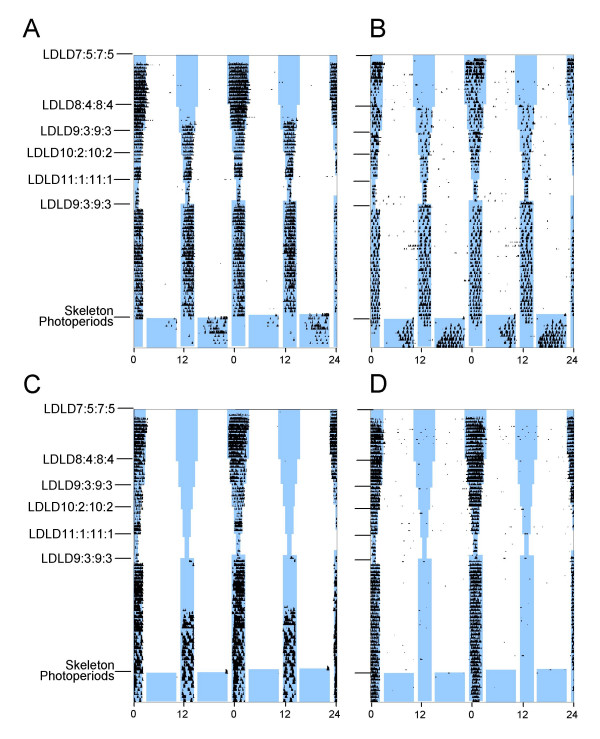
Representative double-plotted wheel-running actograms of Siberian hamsters transferred in Experiment #2 from LD14:10 to LDLD7:5:7:5 and subsequently to other photocycles as noted on the left margins of actograms. Other conventions as in Figure 1. Animals in (A) and (B) demonstrated split behavior very early on in the experiment and remained split until skeleton photoperiods were introduced. The subject in (C) showed no signs of splitting until a second exposure to LDLD 9:3:9:3 and then maintained the split entrainment pattern under skeleton photoperiods. The hamster in (D) exhibited no signs of splitting at any point during the experiment.